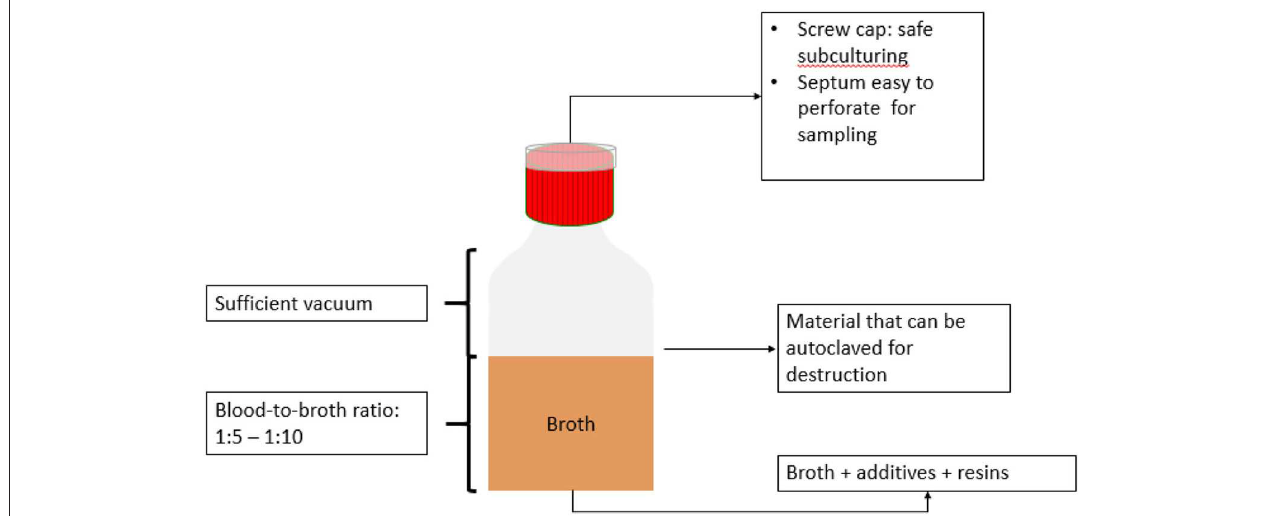
FIGURE 8 | Dissection of blood culture